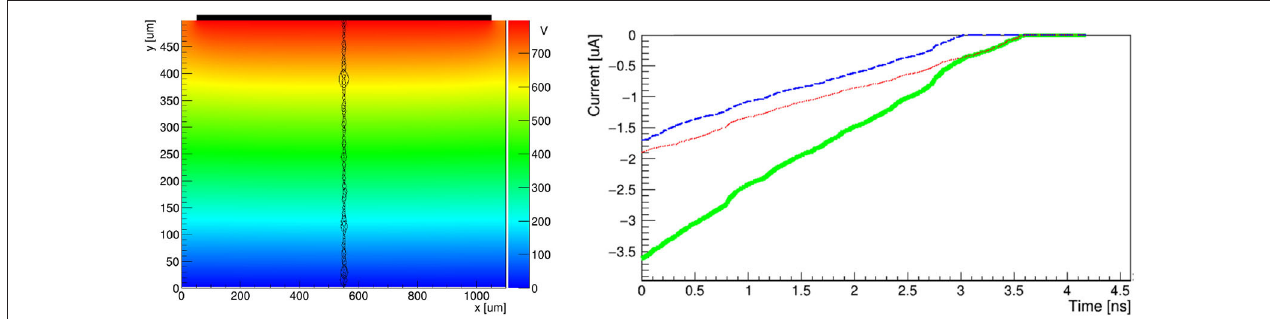
FIGURE 2 | Signal produced by a MIP passing through a 500 µ m diamond simulated using Weightfield2 [26]. On the left: the electric potential inside the diamond and the energy lost by a passing particle. The energy lost in a µ m is represented as a black circle which radius is proportional to the charge released (Landau distribution). On the right are plotted the currents induced by the electrons (dotted red line), holes (dashed blue line) and the sum of the two contributions (solid green line).